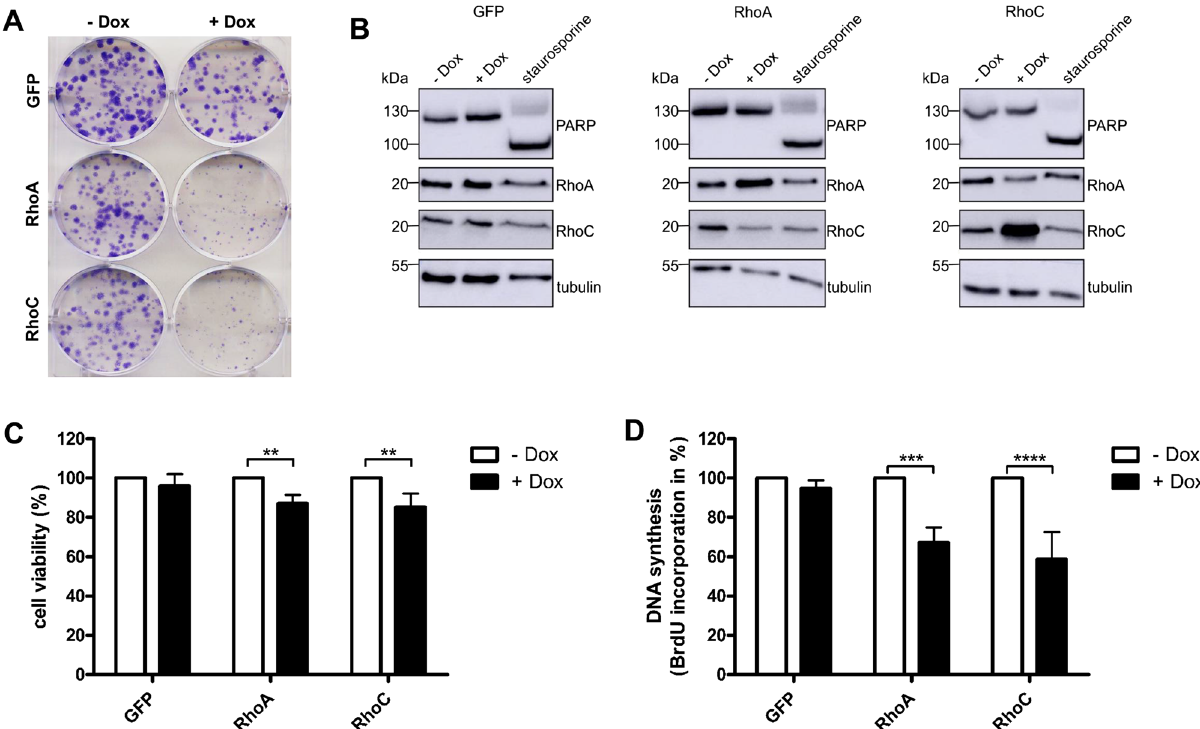
Figure 1. Expression of RhoA or RhoC inhibits proliferation of MCF10A cells. MCF-10Atet cells were transfected with RhoA plus GFP (RhoA), RhoC plus GFP (RhoC) or GFP (GFP, empty vector control)- containing constructs under the control of a tet-ON-promoter. Expression of GFP/Rho was induced by addition of 2 µg/ml doxycycline. ( A ) Crystal violet-stained colonies of GFP-, RhoA- or RhoC-expressing cells after 6 days treatment with (+ Dox) or without (−Dox) doxycycline (n = 3). ( B ) Analysis of apoptosis induction after expression of RhoA, RhoC or GFP for 48 h, respectively. PARP cleavage was detected by Western Blot analysis. Treatment of the cells with 1 µM staurosporine for 16 h was used as a positive control. Representative Western Blots of three independent experiments are shown. Tubulin was used as a loading control. ( C ) Cell viability was measured following expression of RhoA, RhoC or GFP for 48 h. Metabolic activity was normalized to not induced cells. Data of three independent experiments were quantified and analyzed using two-way ANOVA. ( D ) BrdU incorporation after 48 h expression of RhoA, RhoC or GFP was measured to quantify the proliferation of MCF10A cells. DNA synthesis was normalized to the not induced cells. Data of three independent experiments were quantified and analyzed using two-way ANOVA. **p < 0.01, ***p < 0.001, ****p <